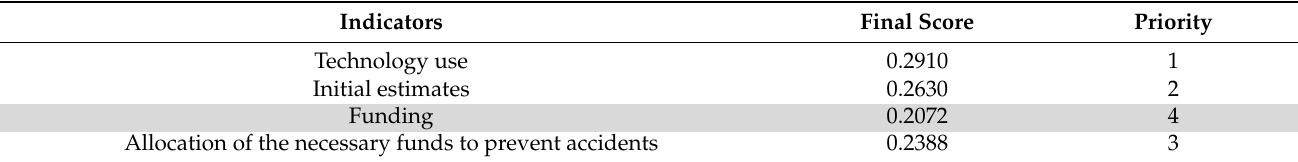
Table 13. Priority related to resource indicators.